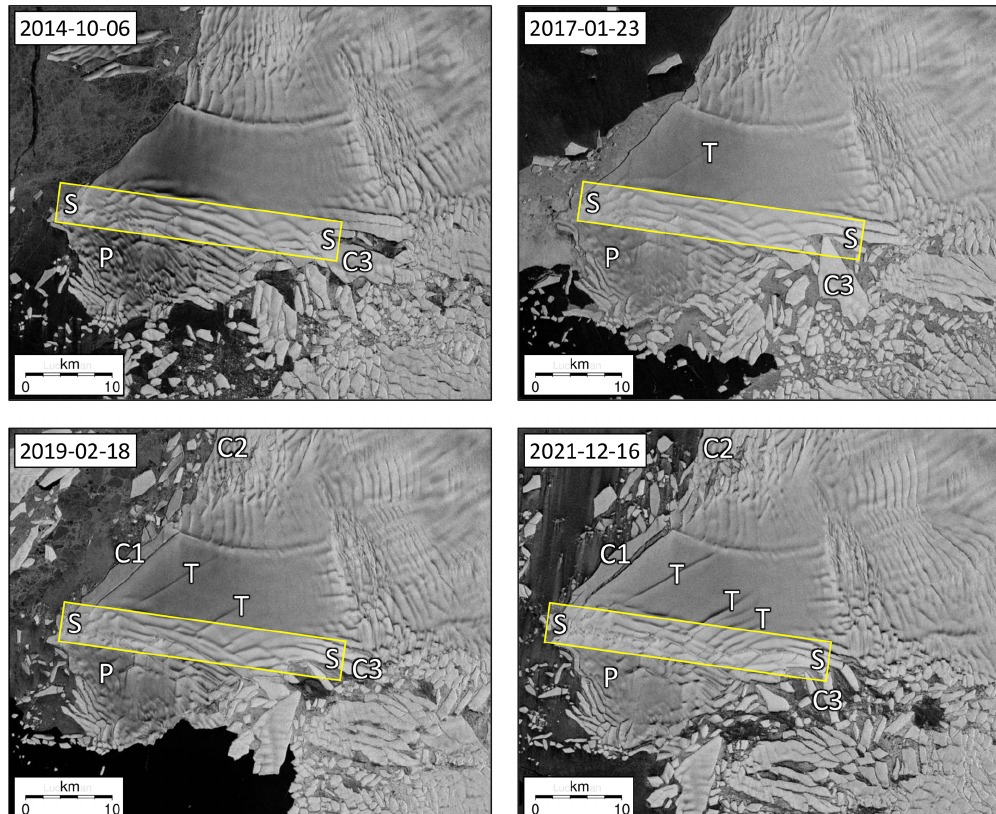
Figure 3. Fracture patterns on TEIS 2014–2021. Labels indicate key features described in the text: S–S: TEIS shear zone; T: tensile cracks; C1–C3: calving along rifts; P: slow-moving, relatively intact ice above pinning